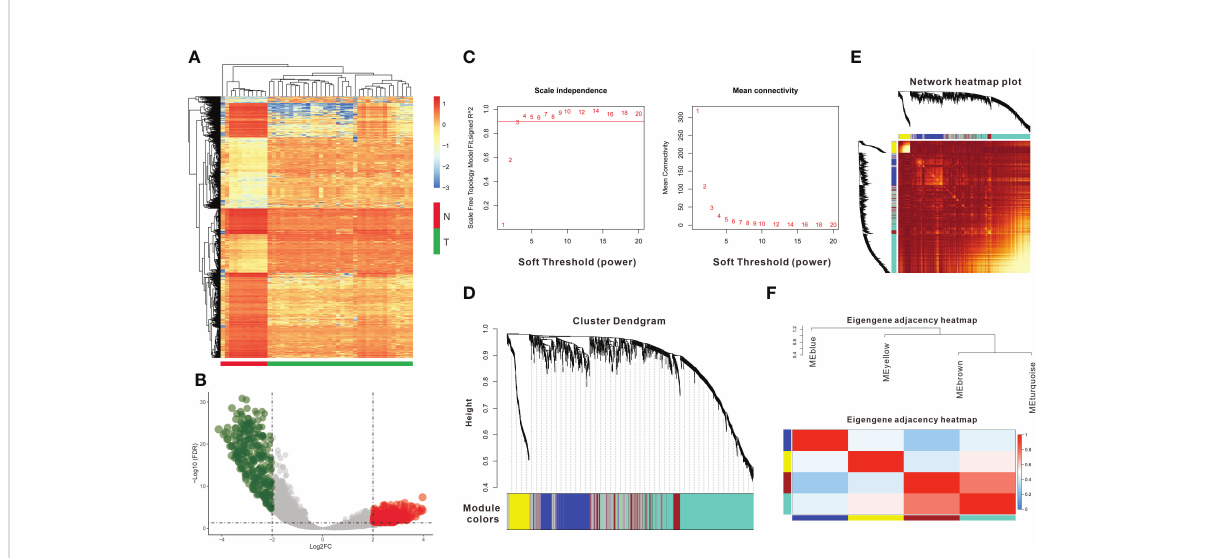
FIGURE 1 Identi fi cation of DEGs and coexpression modules. (A) The heatmap plot shows DEGs between tumor and normal tissues in CCA. (B) The volcano plot shows 849 genes downregulated and 682 genes upregulated in tumor tissues. (C) Determination of the soft thresholding power ( b ) for a correlation coef fi cient of 0.9, as shown by the red line in the left panel. (D) Clustering dendrograms show that four coexpression modules could be constructed based on all DEGs. (E) Network heatmap plot of the four modules; light red indicates a more signi fi cant correlation between genes, whereas darker red indicates a weaker correlation. (F) The eigengene adjacency heatmap shows the correlations between the 4 modules.DEGs: differentially expressed